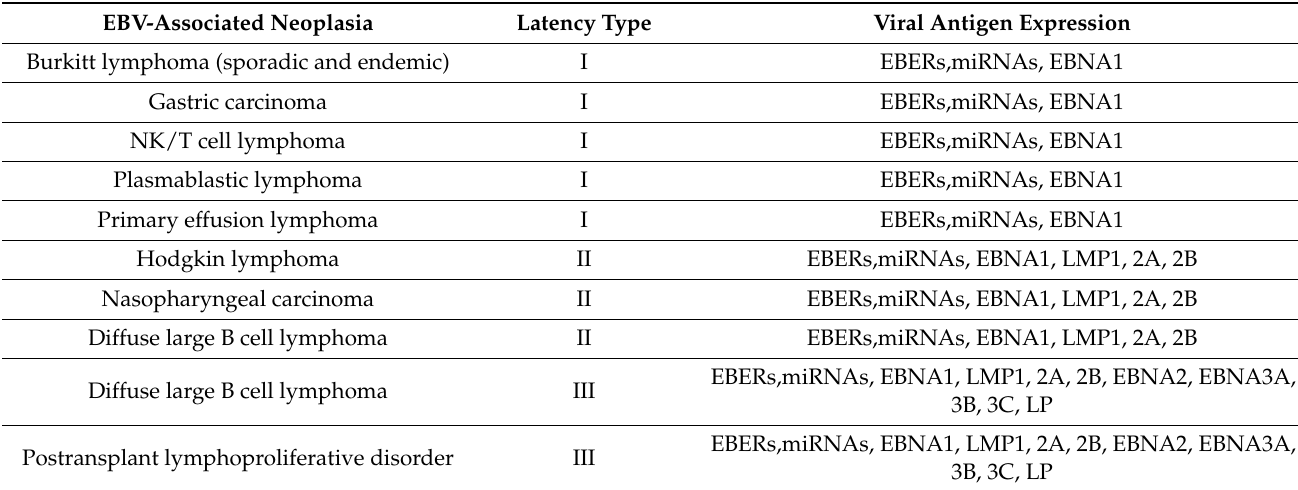
Table 2. EBV latency patterns in viral associated